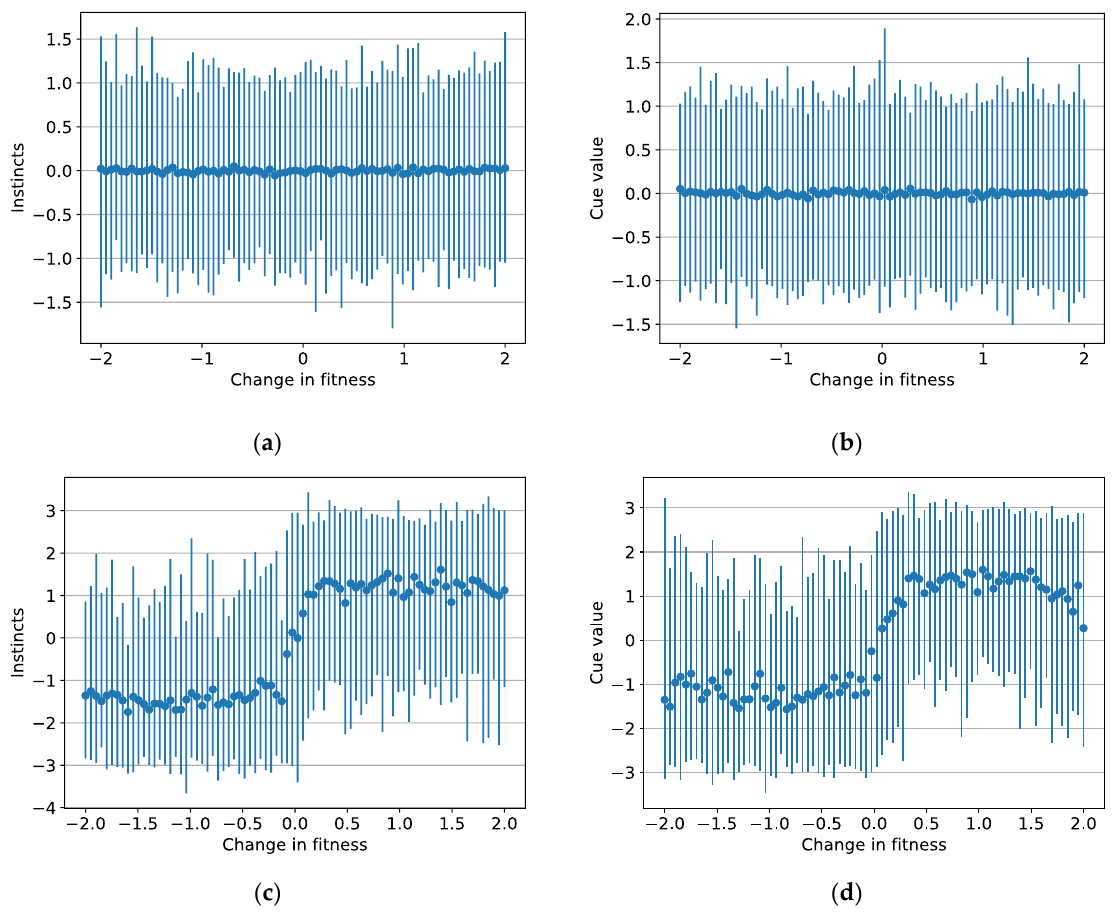
Figure 3. ( a ) Mean instincts for the first generation; ( b ) mean cue values for the first generation; ( c ) mean instincts for the last generation; ( d ) mean cue values for the last generation. Each point represents the population mean for one of the 80 situations, and each corresponding vertical bar shows the range within the population.